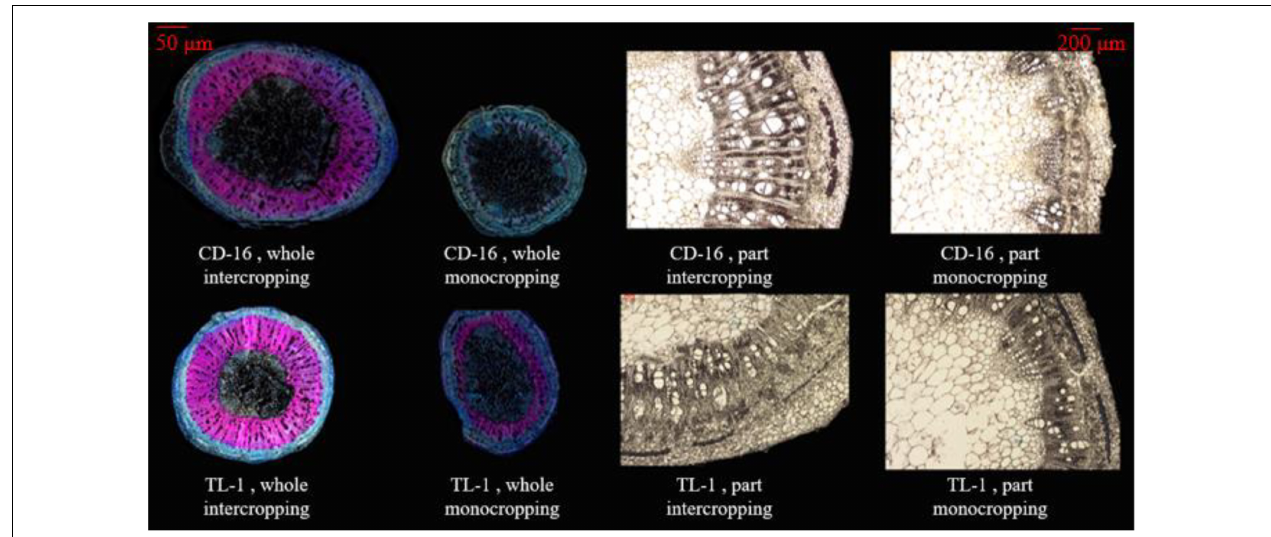
FIGURE 3 | The anatomical structure of soybean stem, whole section (left) , and local section (right) . The xylem in the stem is dyed pink by turning safranin, using to characterize the LC. The phloem in the stem is dyed light blue by fixed o-fast green dye, using to characterize the cellulose content. In the local section, the white bundle structure is the vascular